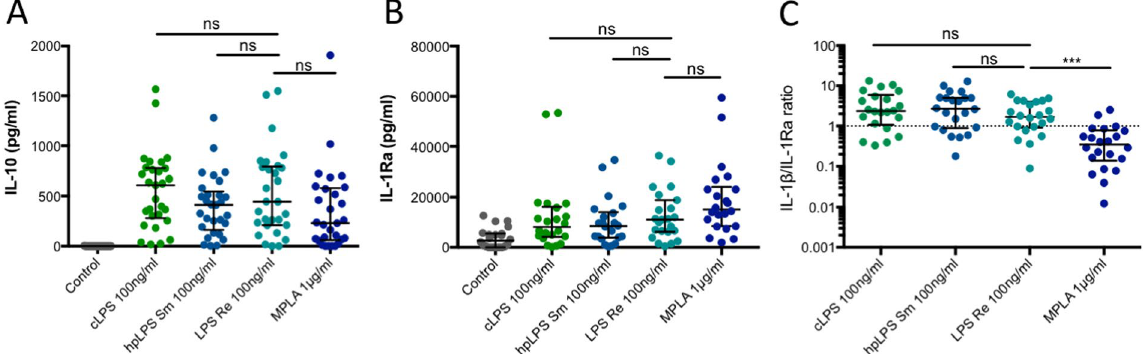
Figure 2. ( A ) IL-10 and ( B ) IL-1Ra production by human adherent mononuclear cells activated with either conventional smooth E. coli O111:B4 LPS (cLPS) (100 ng/ml), highly purified S. abortus equi LPS (hpLPS) (100 ng/ml), highly purified rough S. minnesota LPS (ReLPS) (100 ng/ml) or MPLA (1 µ g/ml) for different donors. ( C ) Ratios between IL-1 β and IL-1Ra for individual donors. Each dot represents one individual donor. *** p <